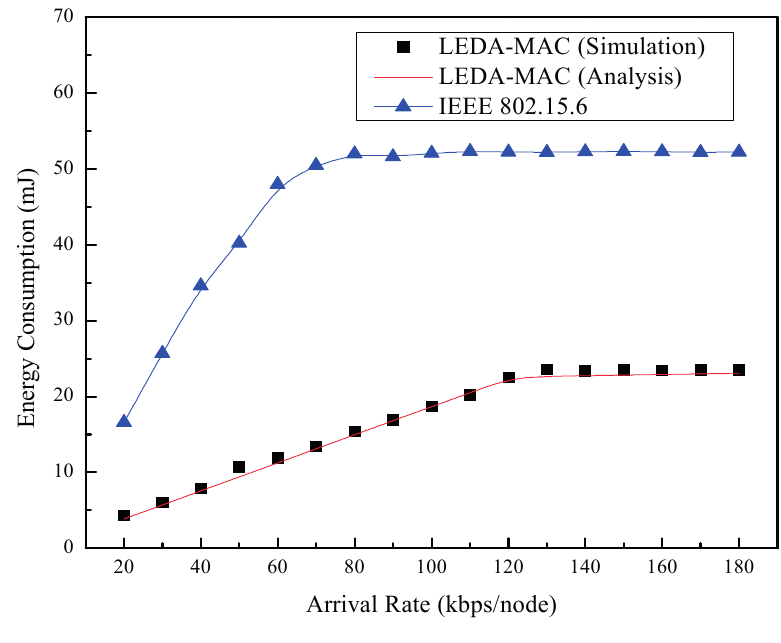
Figure 15. Total energy consumption vs. arrival rate.